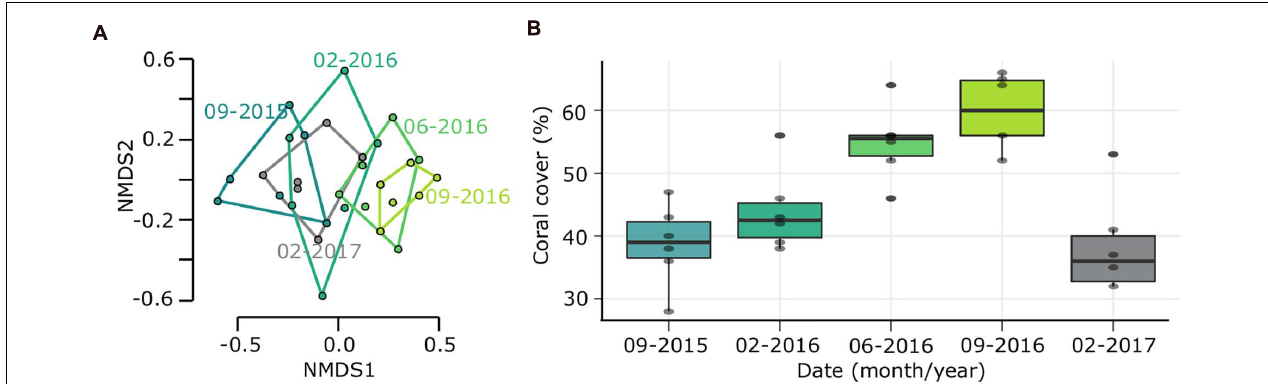
FIGURE 4 | Ecological costs due to Hurricane season 2016-2017. (A) Non-metric multidimensional scaling (NMDS) analysis based on species composition in outplanted site ZT1 over time. (B) Change in coral cover over time.